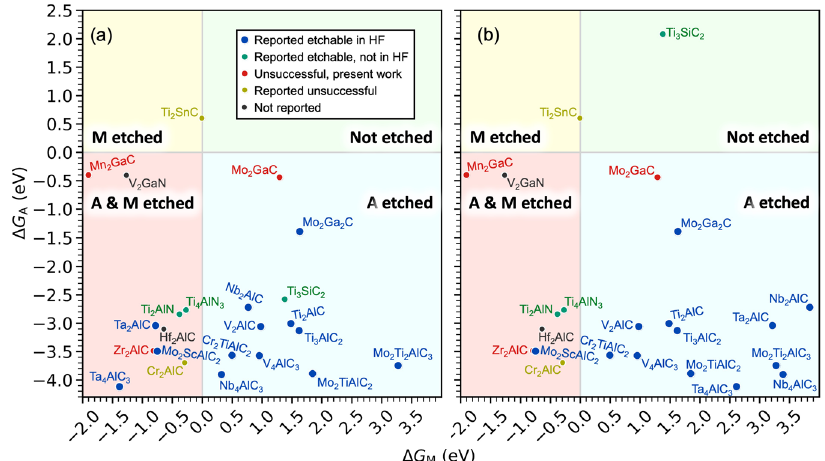
Fig. 2 Initial etching of MAX phases accessed from vacancy formation energies. Free energy of vacancy formation of removing one A element ( Δ G A ) compared to an M element ( Δ G M ) for different MAX phases, calculated using Eq. (4), a without constraints and b with the constraint of excluding ions and molecules containing oxygen when evaluating the chemical potentials for the A and M elements. In the case of Mo 2 Ga 2 C, the formation of free energy (per atom) for removing two Ga atoms is shown since this material has a double A layer. The background is color-coded with respect to the expected etching behavior of the MAX phases found in the respective quadrant, as indicated. Calculated for pH = 0 and an ion concentration of 10 − 3 mol dm − 3 .